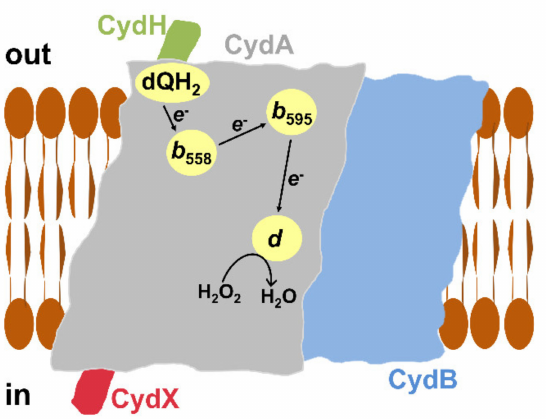
Figure 7. Proposed peroxidase-like activity of cytochrome bd -I from E. coli . Shown is the scheme for the enzyme arrangement in the E. coli membrane bilayer based on the solved bd -I structure [28,29]. The oxidase consists of four different subunits, CydA, CydB, CydX, and CydH. CydA carries three hemes ( b 558 , b 595 , d ) and the quinol binding site at which the electron donor dQH 2 ) is likely